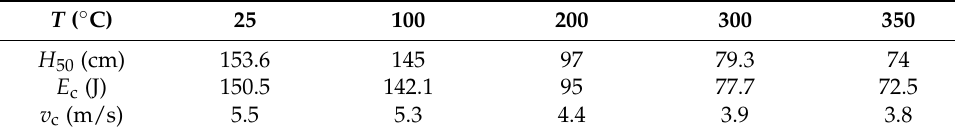
Table 2. The calculated results of drop-weight tests.